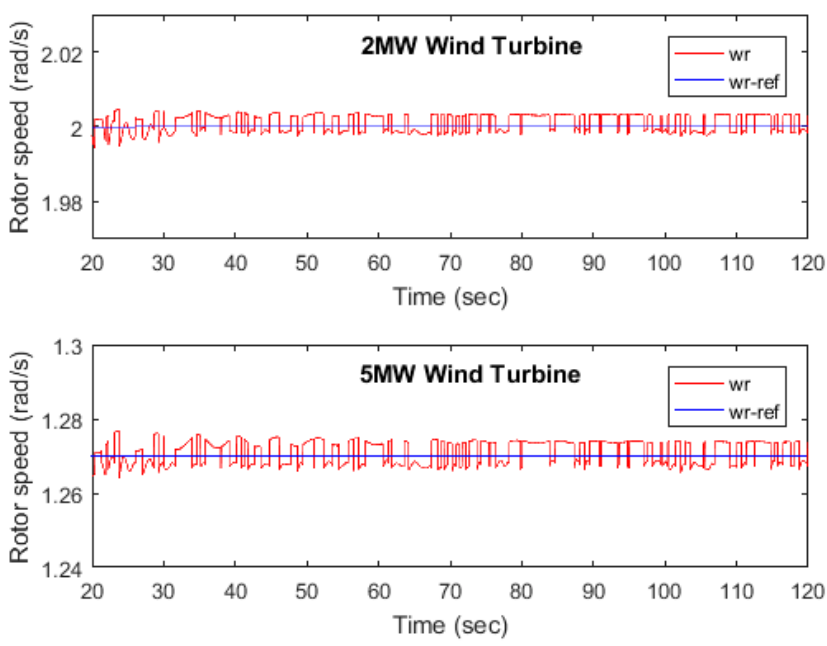
Figure 12. Steady-state rotor speed tracking of the 2 MW and the 5 MW wind turbines.